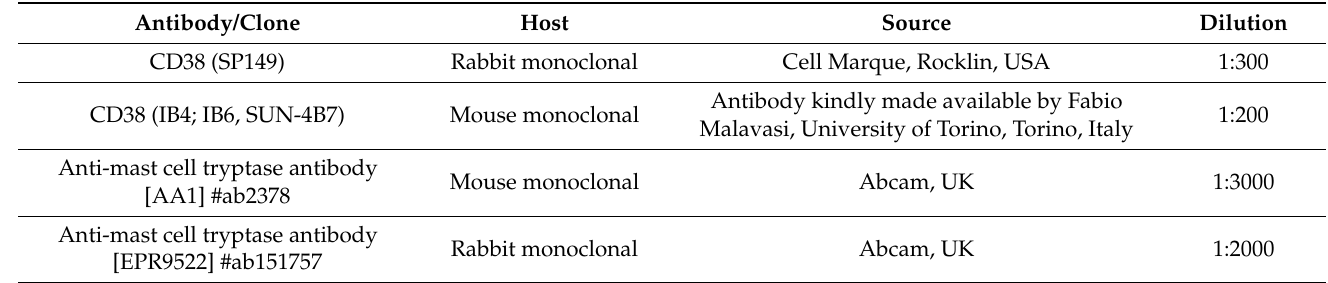
Table 1. Primary antibodies used in this study.